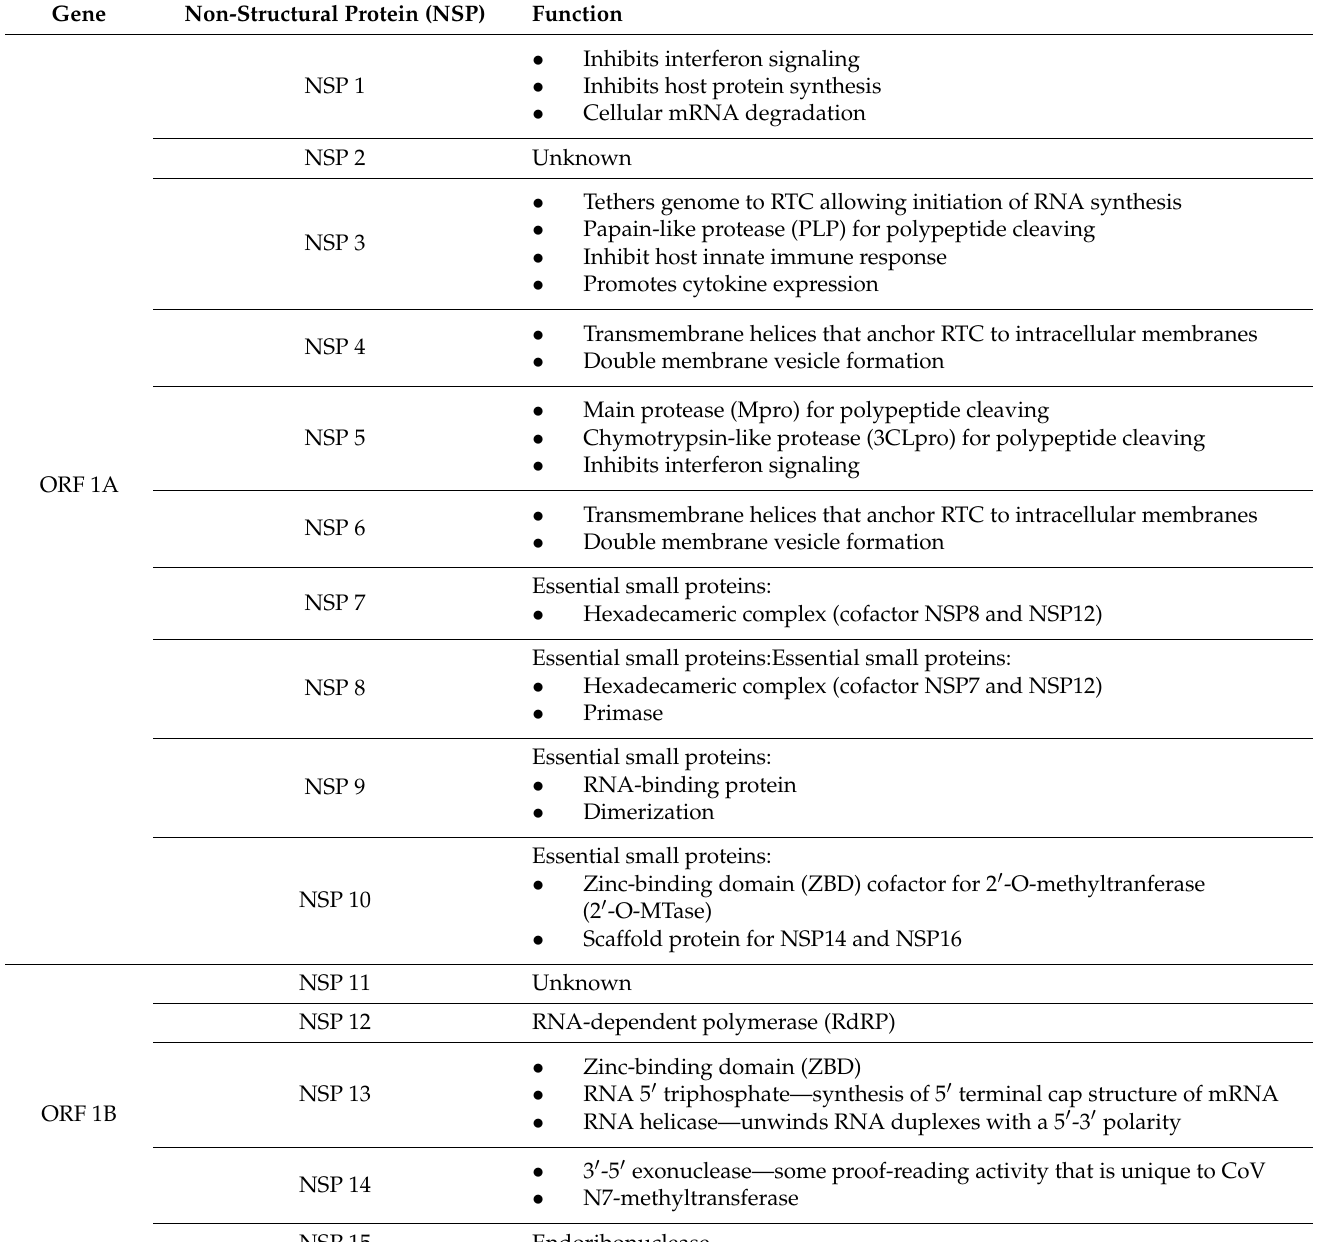
Table 1. Function of 16 non-structural proteins (NSPs) translated from the CoV genome. NSP1-10 is translated from ORF1A, whereas NSP11-16 is translated from ORF1B.